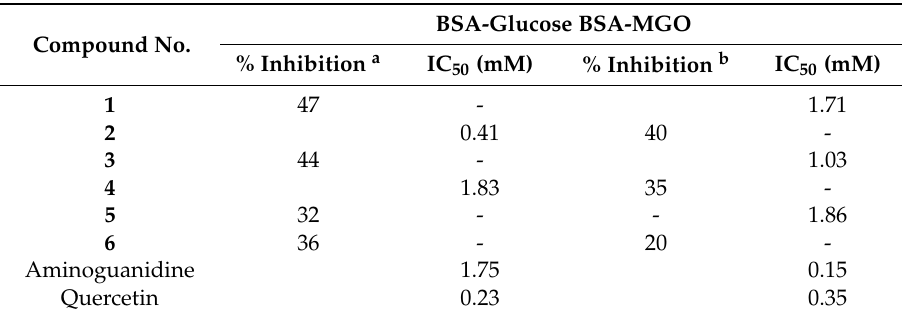
Table 3. Antiglycation (AGEs) activity of compounds 1 – 6 .